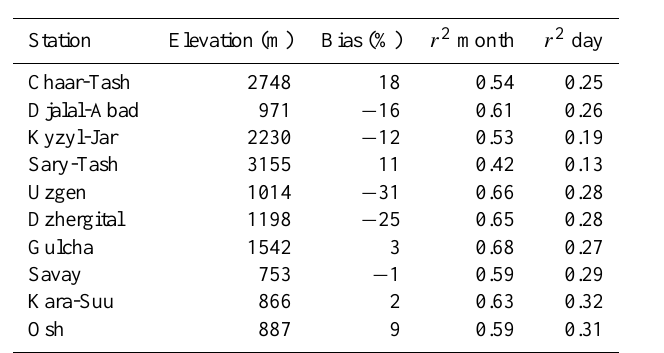
Table 5. Comparison of observed and WRF simulated precipitation at the station locations: bias, daily and monthly squared correlation coefficient calculated over the period 1960–1990.